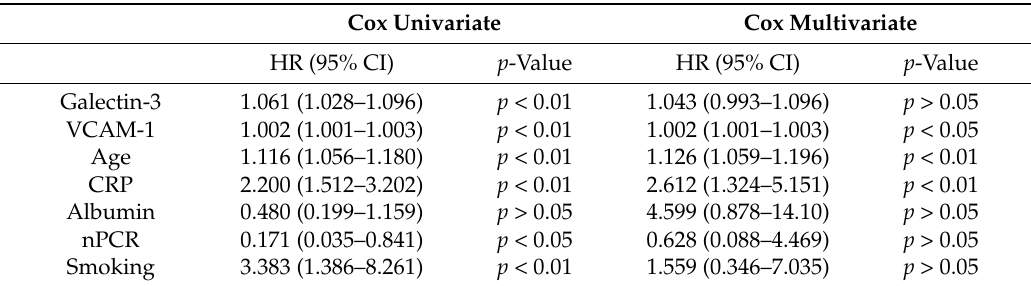
Table 4. Univariate and multivariable Cox regression analysis of prognostic factors for CV